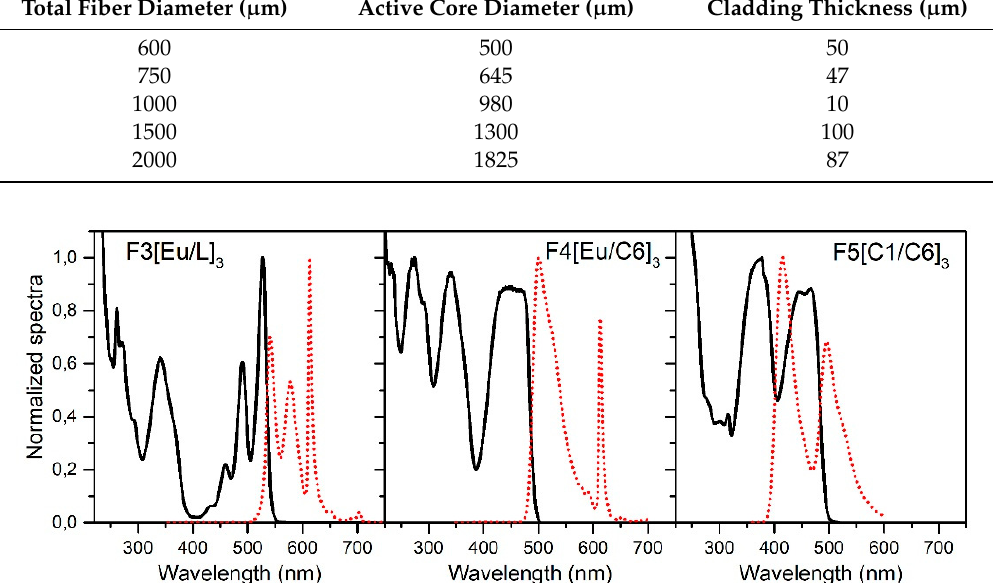
Figure 2. Photographs of the solutions before ( left ) and after ( right ) polymerization under environmental lighting and UV excitation.